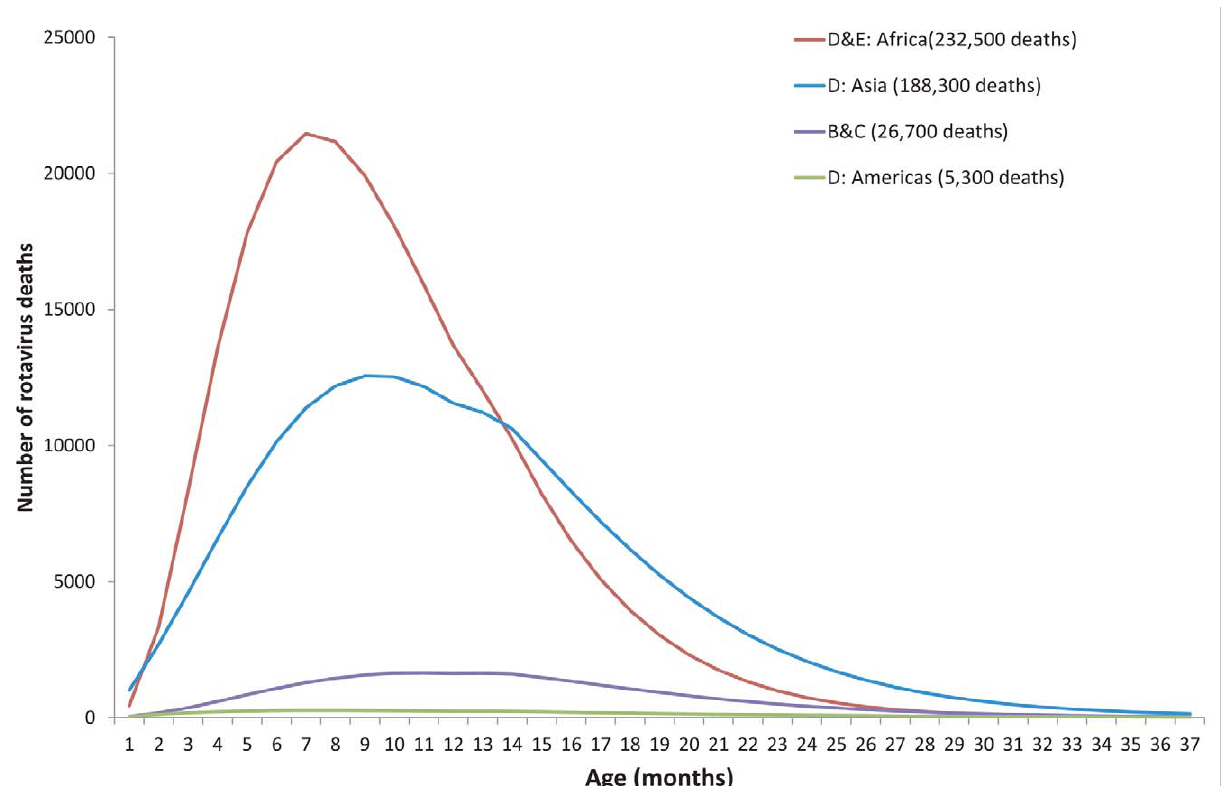
Figure 1. Age distribution of rotavirus deaths among children under 5 y, by WHO mortality group.